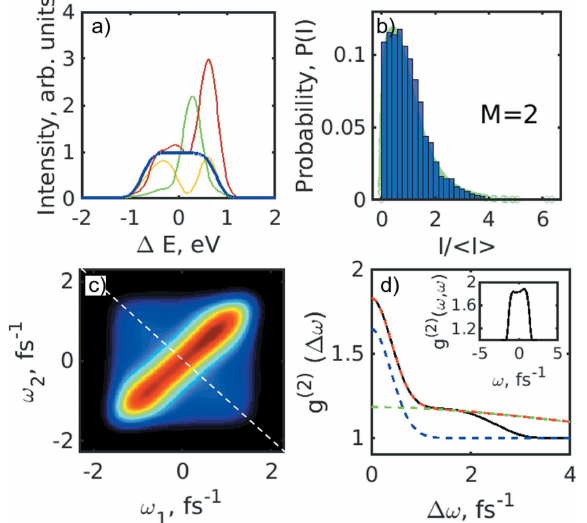
Figure 9 Spectral analysis simulation with the monochromator installed in the beamline. ( a ) Simulated profiles of single-pulse intensities and an averaged spectrum (blue line) with a bandwidth of 1.9 eV. ( b ) Histogram of intensities of single pulses obeying the gamma function distribution (green background) with number of modes M = 2. ( c ) Second-order intensity correlation function g (2) ( ! 1 , ! 2 ) of the simulated spectra with the monochromator. ( d ) Second-order intensity correlation function g (2) ( (cid:2) ! ) (black curve) taken along the white dashed line in ( c ) and its fit (red dashed line) with equation (9). In the inset the profile of the g (2) ( ! , ! ) function along the diagonal in ( c ) is shown.